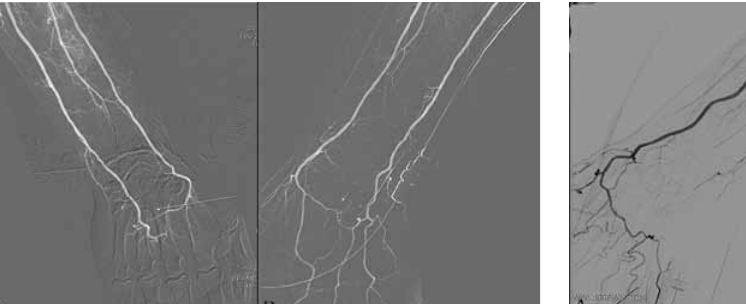
Figure 1. Selective angiography shows patent forearm arteries, but the palmar arch is not complete (see arrows).